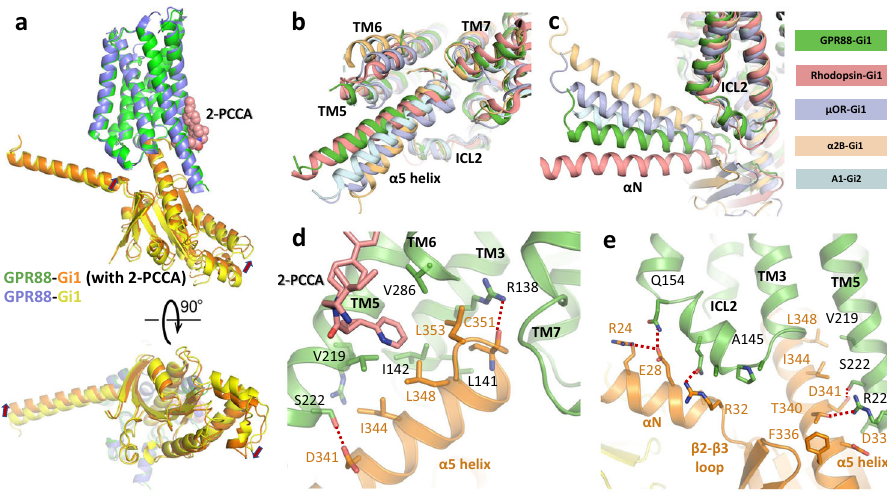
Fig. 5 GPR88-Gi1 interface. a Comparison of the GPR88-Gi1 complex with or without 2-PCCA. Red arrows indicate the shift of G-protein. b , c Superimposition of the receptor G-protein coupling interfaces for GPR88-Gi1, rhodopsin-Gi1 (PDB:6CMO), μ OR-Gi1 (PDB:6DDE), α 2B AR-Gi1 (PDB:6K42), and A1R-Gi2 (PDB:6D9H). d Interactions of GPR88 with the α 5 helix of G α i1. e Rotated view of interactions of GPR88 with the α 5 and α N helices of G α i1. Polar interactions are highlighted as dash